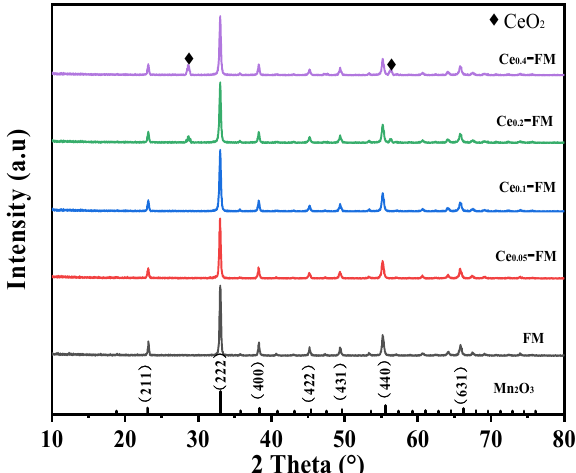
Figure 3. XRD patterns of Ce x -MF catalysts.